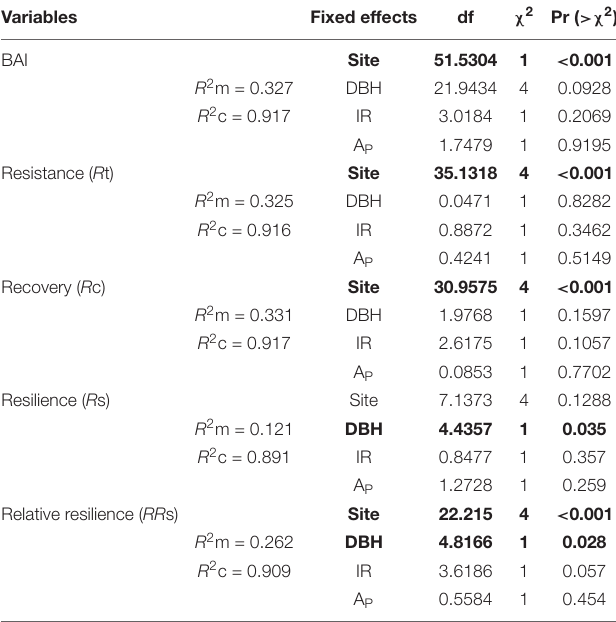
TABLE 3 | Results of the log likelihood ratio test for the linear mixed model with site, internal relatedness (IR), private alleles (A P ), and DBH as fixed factors and trees as random